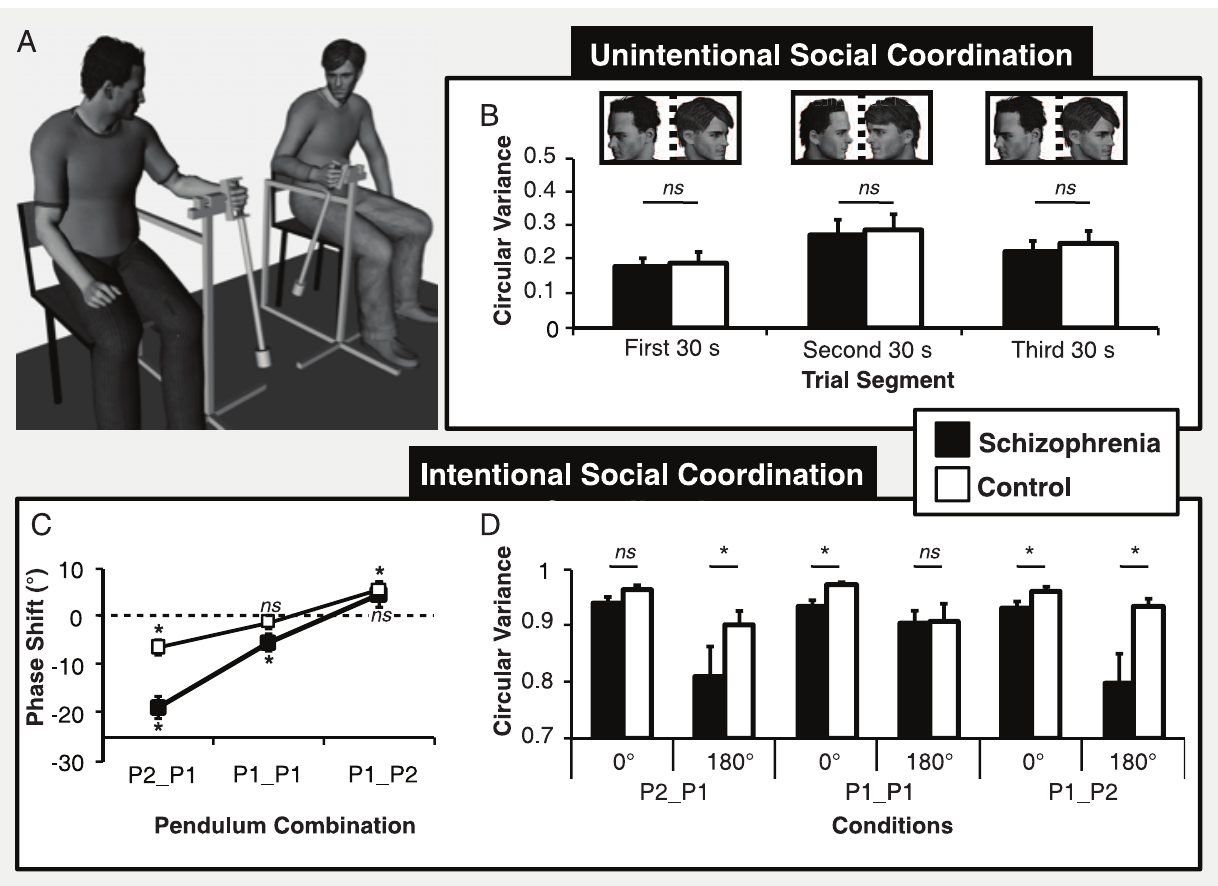
Figure 1. Experimental setup and results for unintentional and intentional social motor coordination. (A) Participants sat on chairs side- by-side while oscillating wrist pendulums. Circular variance of the relative phase for the schizophrenia (black) and control groups (white) as a function of the trial segment for unintentional coordination (B) and of the pendulum combination and the pattern intended for intentional coordination (D). (C) Phase shifts from the intended pattern of coordination as a function of the pendulum combination for the two groups of participants (Asterisks in (C) indicate significant differences from zero). Error bars represent standard error.